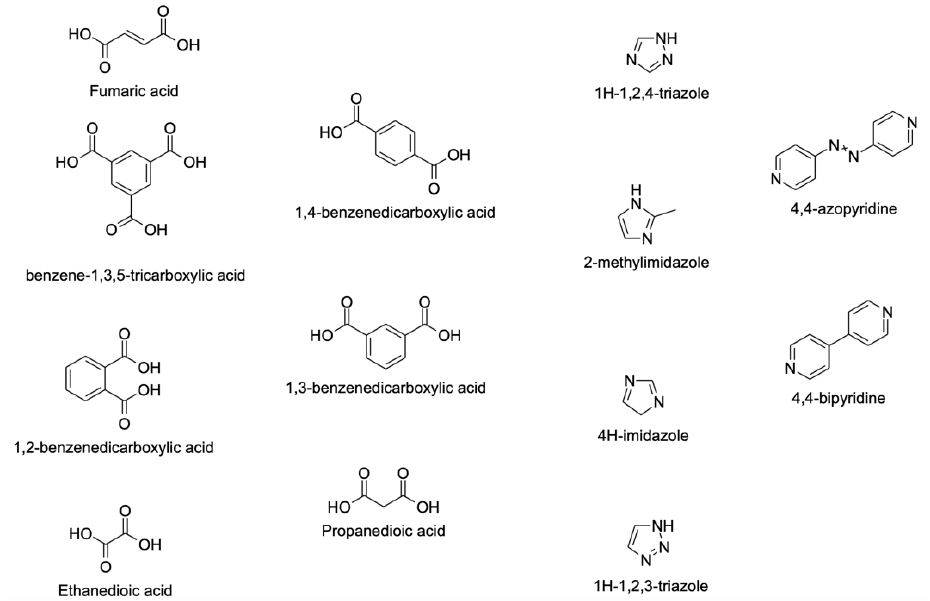
Figure 2. Examples of the chemical structure of common organic linkers used in MOF preparation.